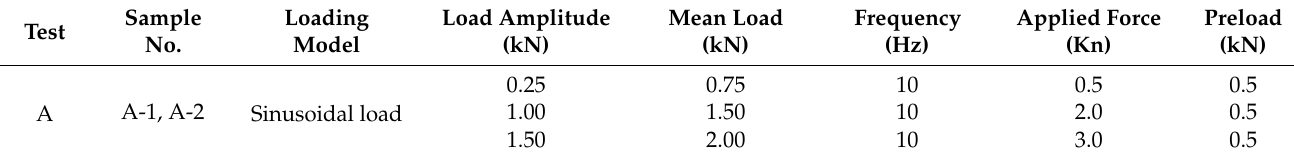
Table 3. Loading scheme of Test A.